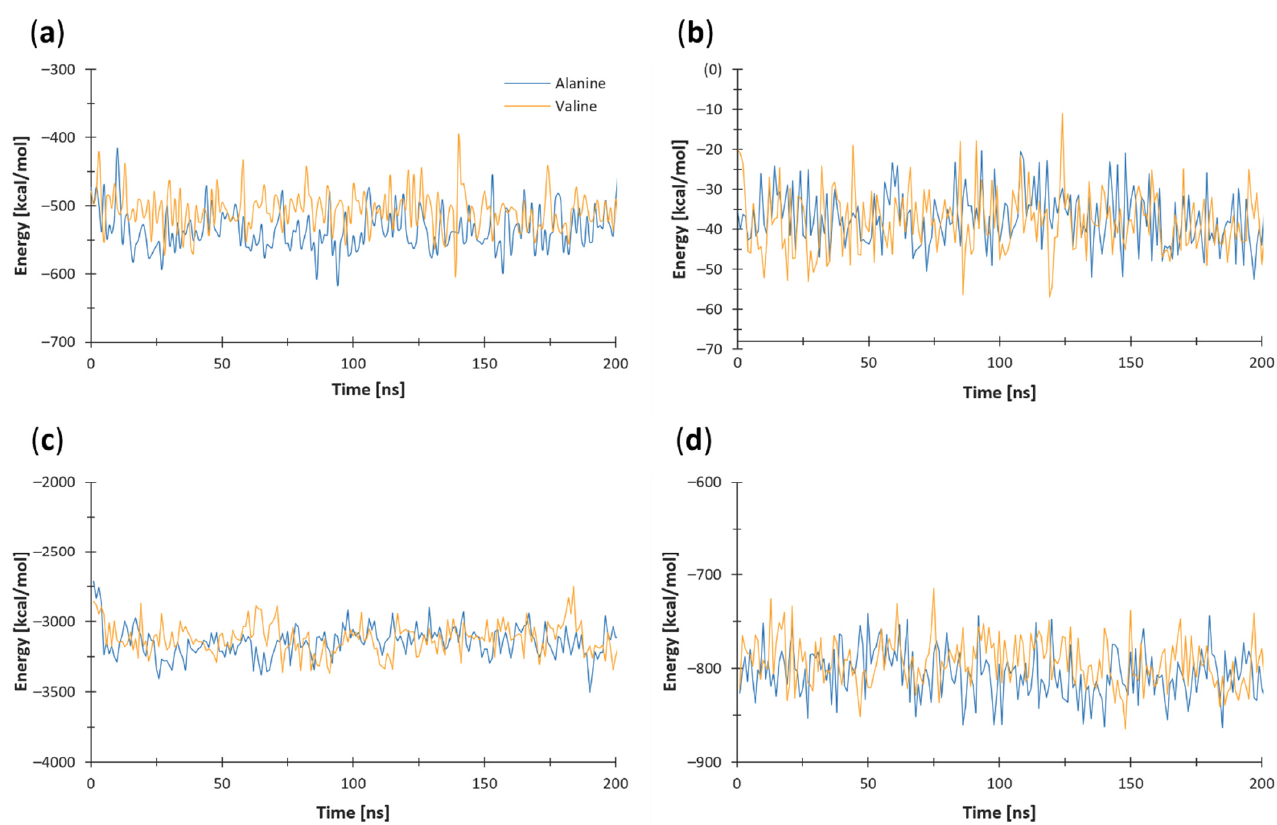
Figure 7. Graphical representation of the intramolecular electrostatic and vdW energy analyses. Lower values indicate a more stable structure. The ( a ) electrostatic and ( b ) van der Waals intramolecular potentials for the MTS domain. The ( c ) electrostatic and ( d ) van der Waals intramolecular potentials for the whole protein. The Ala variant is denoted in blue, while the Val variant is in orange.